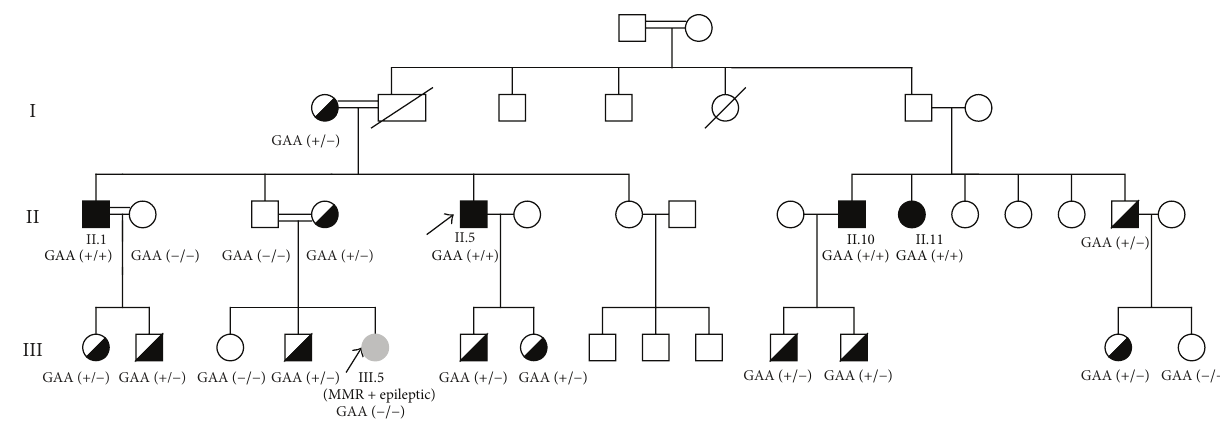
Figure 1: Pedigree of a family with FRDA. Black boxes indicate affected FRDA patients. The index case is indicated by an arrow. Semiblack boxes indicate FRDA carriers. The FRDA( − ) case is indicated by grey box and the number III.5.